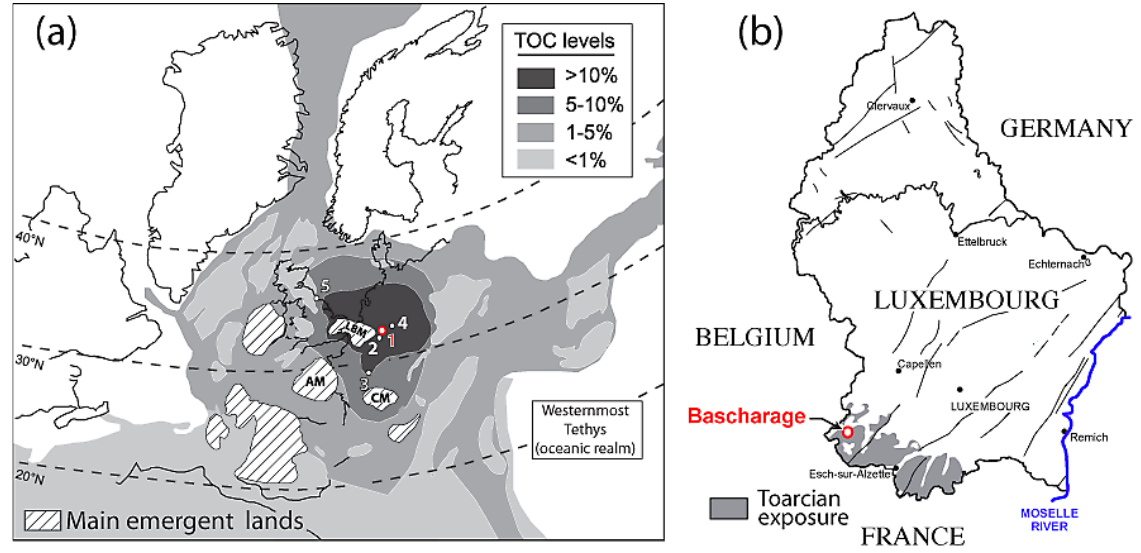
Figure 1. (a) Palaeogeographic reconstruction of the Early Jurassic epicontinental seaway, and geographic distribution of organic-rich rocks. Greyscale shades reflect average contents of total organic carbon (TOC); key is inset upper right. Emergent lands delineating the Paris Basin are hatched. CM – Central Massif, AM – Armorican Massif and LBM – London–Brabant Massif (also comprising the Rhenish Massif in its oriental portion). The map indicates the location of the Bascharage section (1), ANDRA EST433 borehole (2), Sancerre borehole (3), Dotternhausen (4) and Yorkshire coast (5). Source: Bassoulet et al. (1993), Baudin et al. (1990), Van de Schootbrugge et al. (2005), Hermoso et al. (2009). (b) Location of the Bascharage section in NW Luxembourg. The grey area represents exposures of Toarcian deposits. Map from Service Géologique